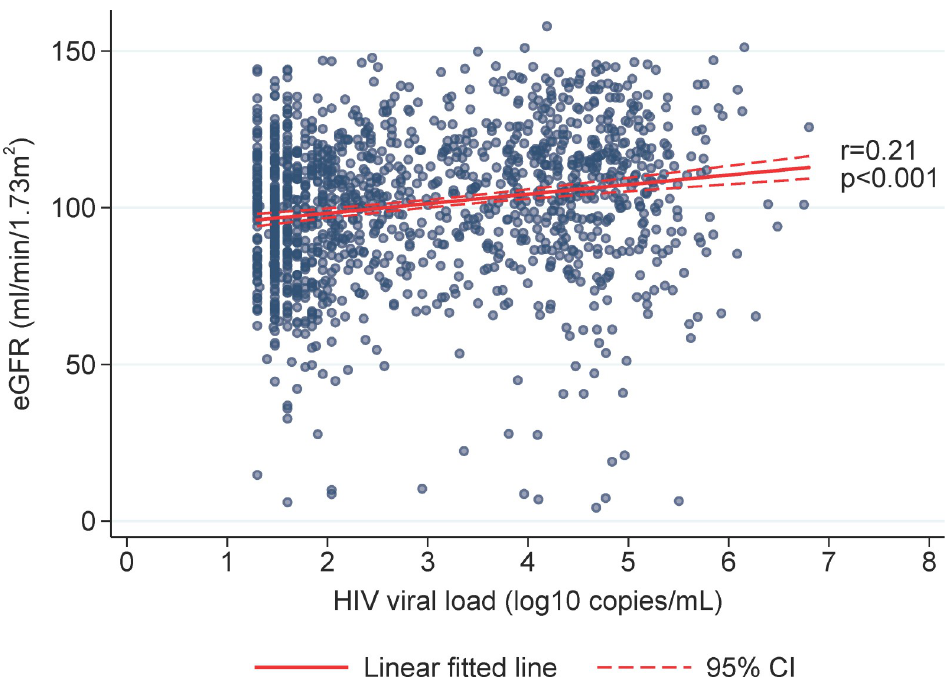
Fig 2. Correlation, eGFR and log10 HIV viral load. Spearman’s correlation test with Bonferroni adjustment for multiple measurements.